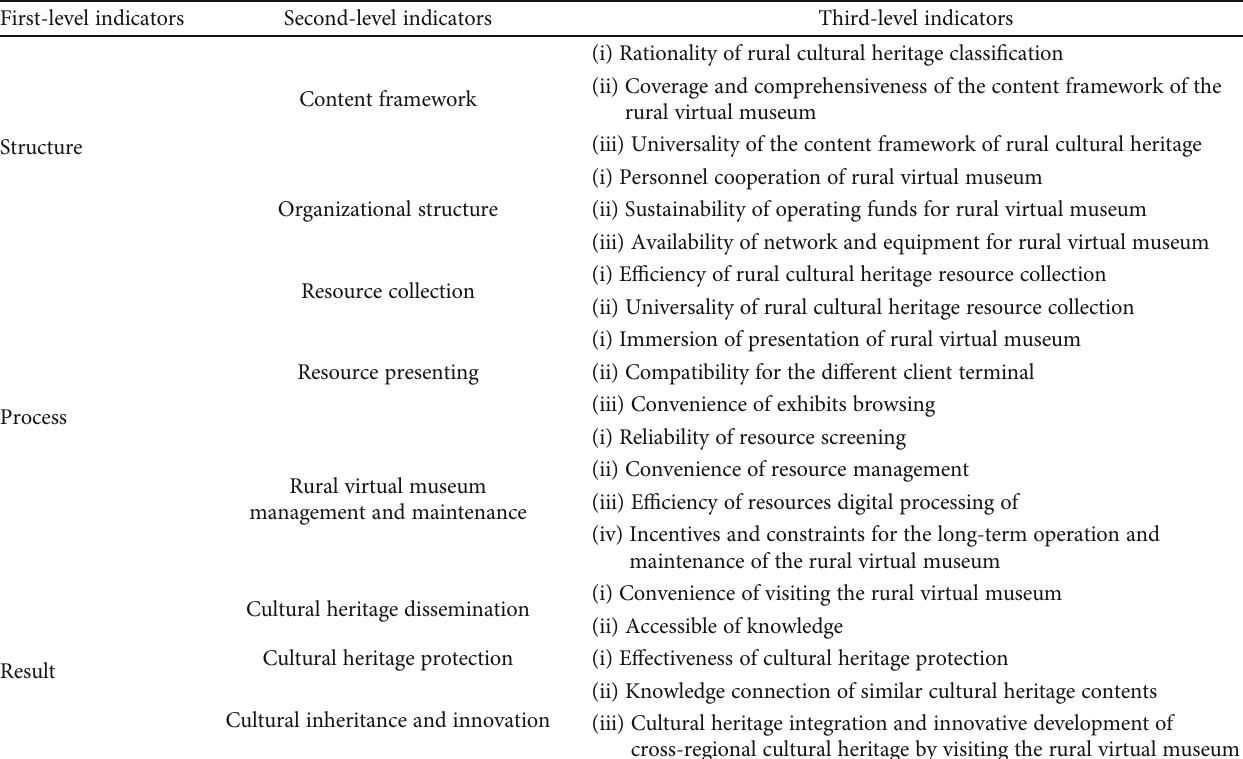
Table 2: The evaluation indicators of rural cultural inheritance mode based on virtual